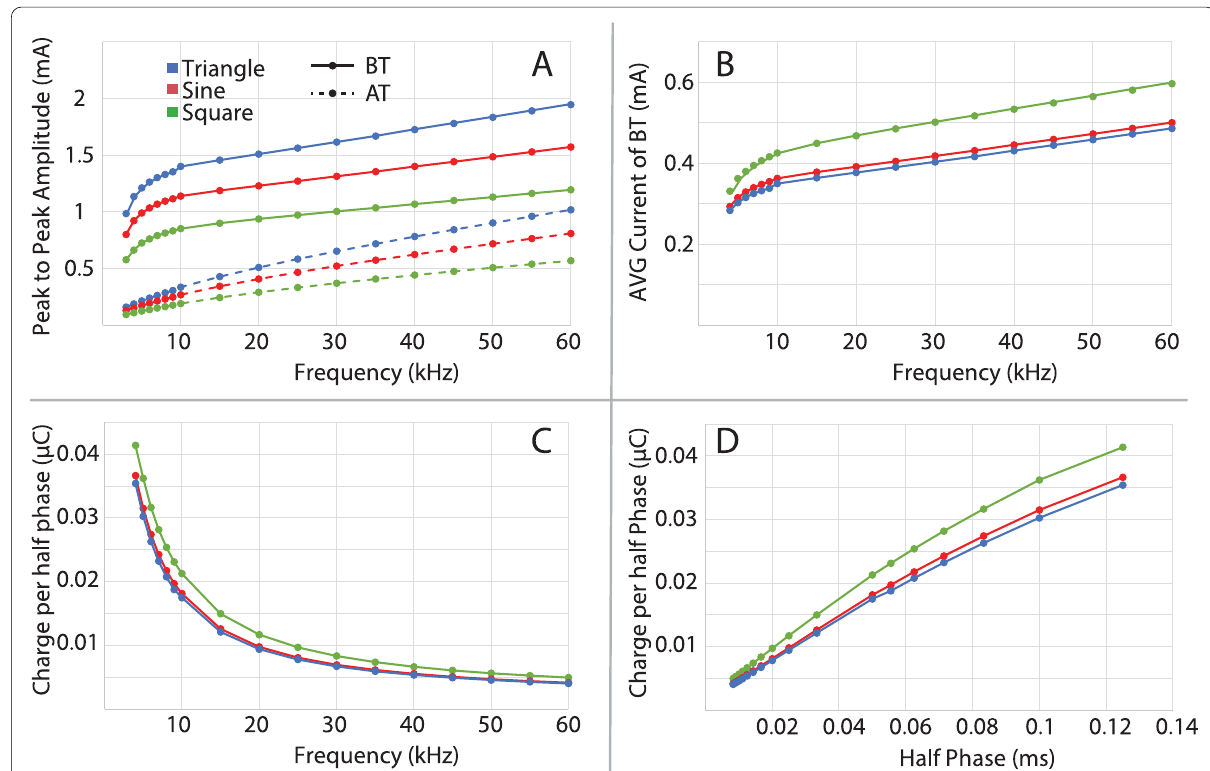
Fig. 4 A Block Threshold (BT) and Activation Threshold (AT) for a 10 μm diameter axon with triangular (blue), sinusoidal (red), and square (green) waveforms. B Average current of all BT values over the frequencies tested. C Charge delivered during a half pulse of the blocking waveform. D Same values as in C but shown over the half pulse duration (inverse of the frequency scale shown in